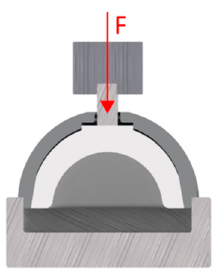
Figure 4. Test Setup Disassembly Test .